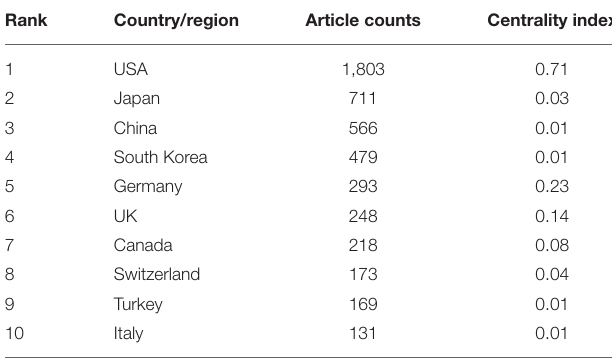
TABLE 1 | The top 10 countries/regions: article counts and centrality of publications in spinal stenosis research. Rank Country/region